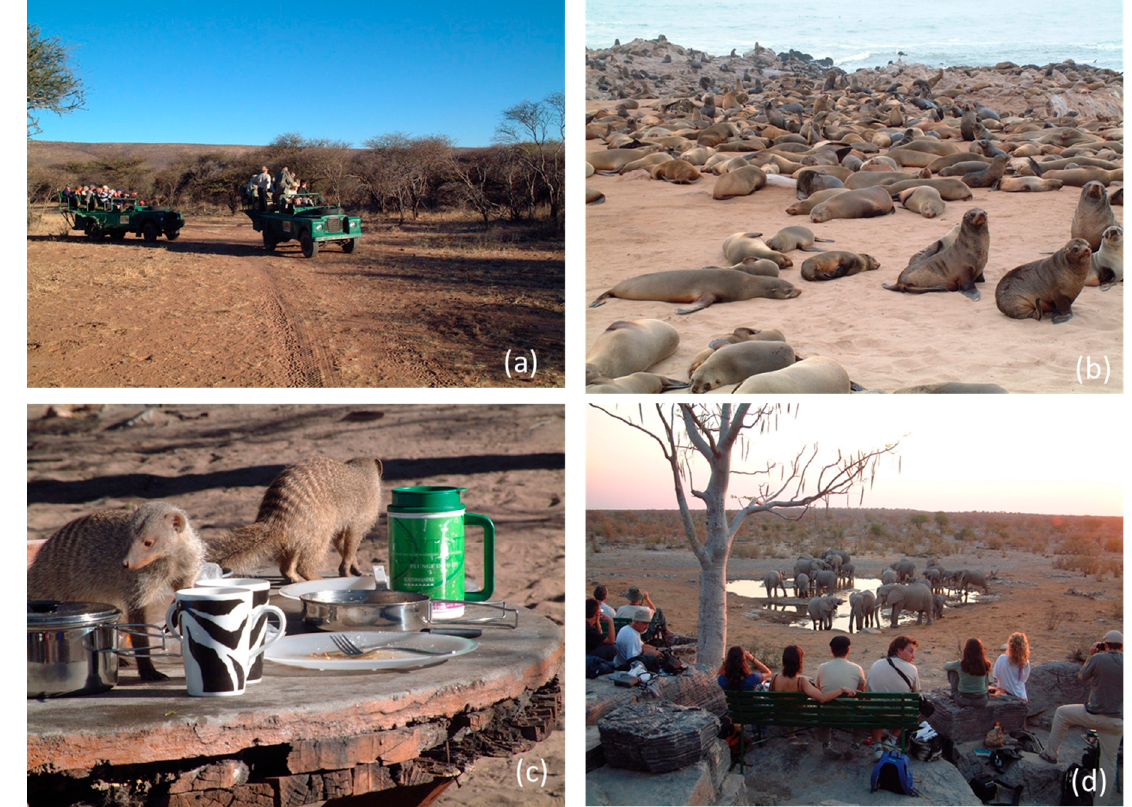
Figure 4. ( a ) Wildlife safari vehicles in Okanjima Game Reserve Namibia, ( b ) Cape Fur Seals are viewed from behind a stone wall in the Cape Cross Seal Reserve Namibia, ( c ) Striped Mongoose freely interact with unconstrained visitors in the Waterberg Plateau National Park Namibia, ( d ) wildlife viewing platform within fenced Halali Camp in Etosha National Park Namibia (Images: D.B. Croft).